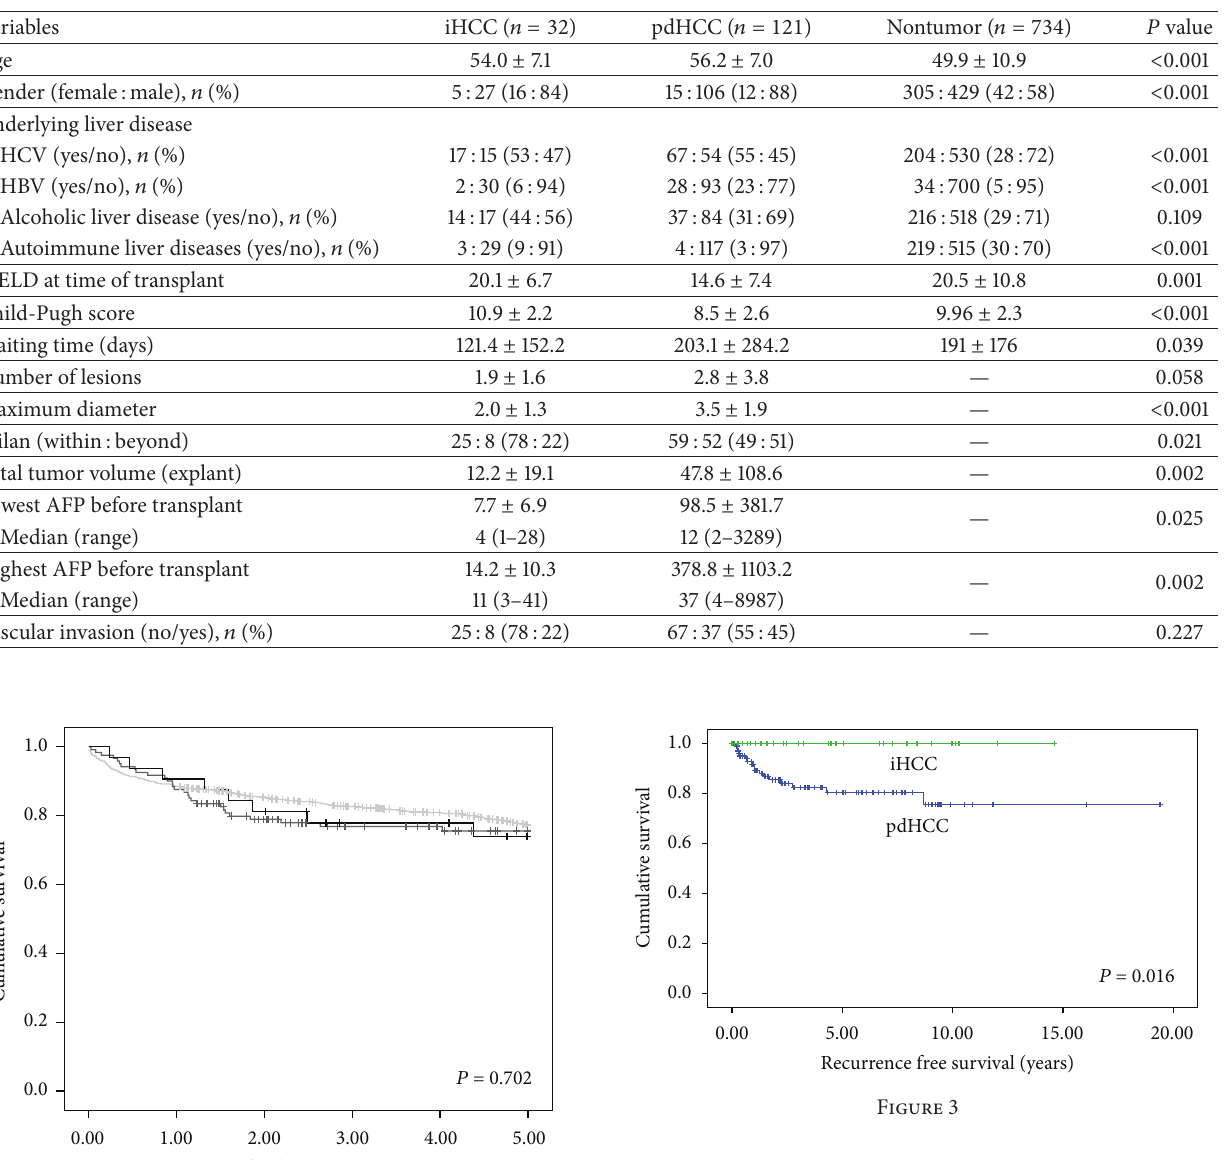
Table 1: Characteristics of patients.